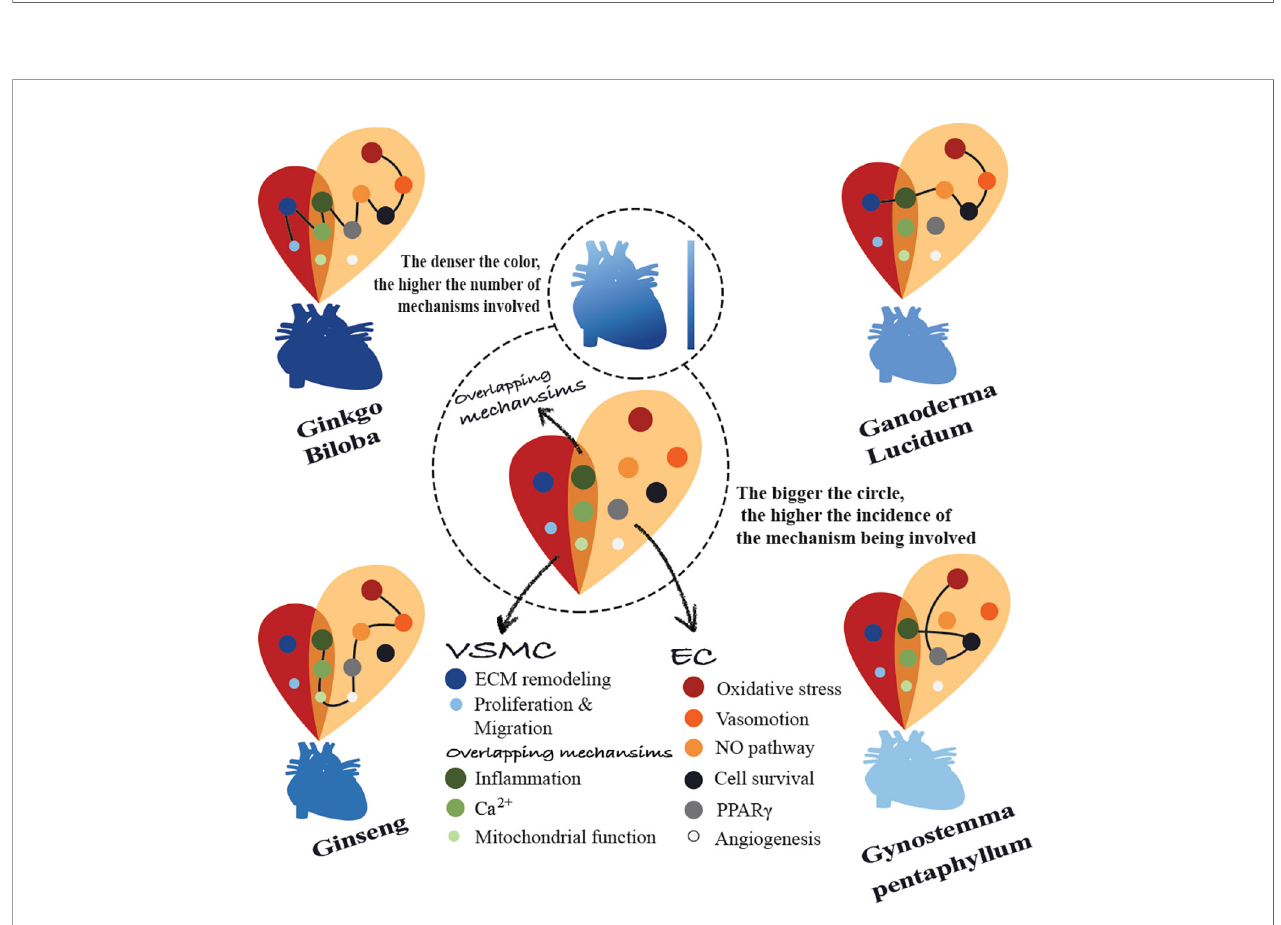
FIGURE 6 | Herbal therapies in the context of CVDs. Herbal preparations can exert protective effects by ameliorating the pathological effects exerted by CVDs risk factors. The herbal extracts can attenuate endothelial dysfunction and/or VSMC alterations by acting as, vasodilators, ROS scavengers, anti-oxidants, anti- in fl ammatory, anti-apoptotic, anti-hypertrophic, or anti-proliferative agents. This achieved through mechanisms that act in ECs only, VSMCs only, or through overlapping mechanism that act in both ECs and VSMCs. In ECs, herbal preparations can increase NO availability, decrease mitochondrial dysfunction and/or metabolic abnormalities as well as enhance angiogenesis. This can decrease the incidence of atherosclerosis and hypertension, which in return can decrease the risk of CVDs development. In VSMCs, the herbal extracts can modulate ECM deposition as well as cell migration, proliferation, and cell shape changes. VSMC, vascular smooth muscle cell; ECM, extracellular matrix; EC, endothelial cell; NO, nitric oxide; PPARY, peroxisome proliferator-activated receptor-gamma.